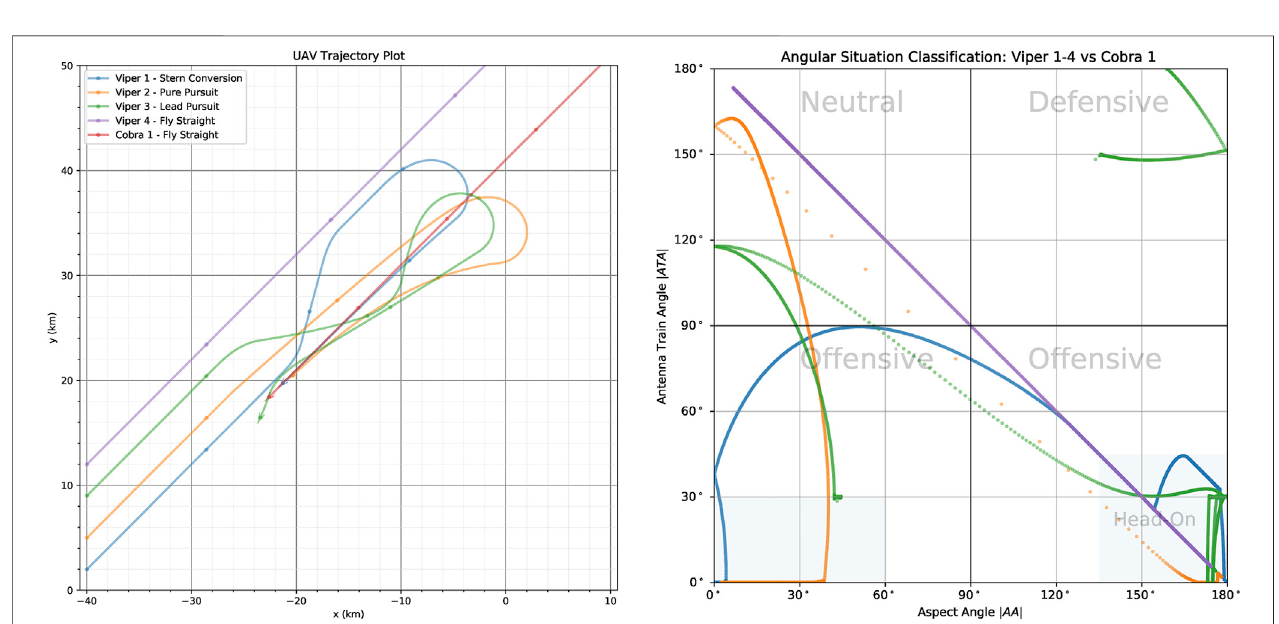
FIGURE 6 | Comparison of behaviours generated by ACE0, showing four aircraft fl ying different behaviours with respect to the red aircraft (Cobra-1) which is implementing Fly Straight .